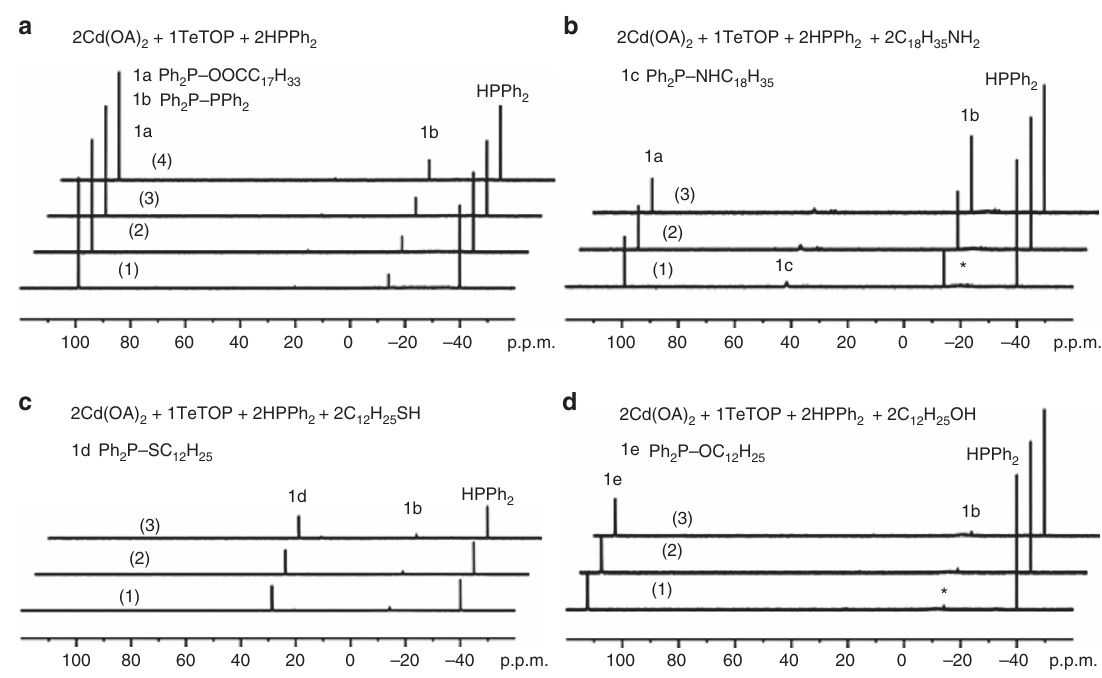
Figure 3 | 31 P NMR spectra of CdTe reaction mixtures with Te precursor. ( a ) 2Cd(OOCC 17 H 33 ) 2 þ TeTOP þ HPPh 2 . ( b ) 2Cd(OOCC 17 H 33 ) 2 þ TeTOP þ HPPh 2 þ 2C 18 H 35 NH 2 . ( c ) 2Cd(OOCC 17 H 33 ) 2 þ TeTOP þ HPPh 2 þ 2C 12 H 25 SH. ( d ) 2Cd(OOCC 17 H 33 ) 2 þ TeTOP þ HPPh 2 þ 2C 12 H 25 OH. The experiments were performed at RT for 15 (1), 30 (2), 45 (3) and 60min (4) for a , and 15 (1), 30 (2) and 60min (3) for the rest. The peak denoted with an asterisk (*) is TOP complexed to Cd (ref.